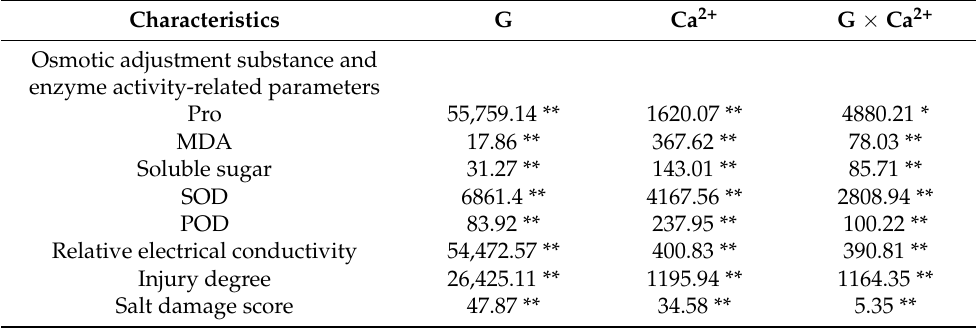
Table 1. ANOVA of the effects of grafting (G), Ca 2+ , and interaction of G and Ca 2+ on osmotic adjustment substance and enzyme activity-related parameters, ion distribution-related parameters, and plant growth-related characteristics. The values shown are F-values. * p < 0.05; ** p < 0.01; ns, not